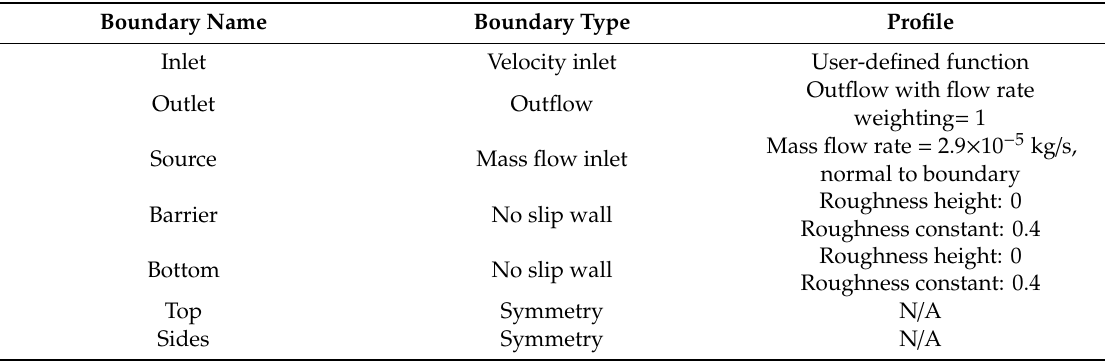
Table 2. Boundary